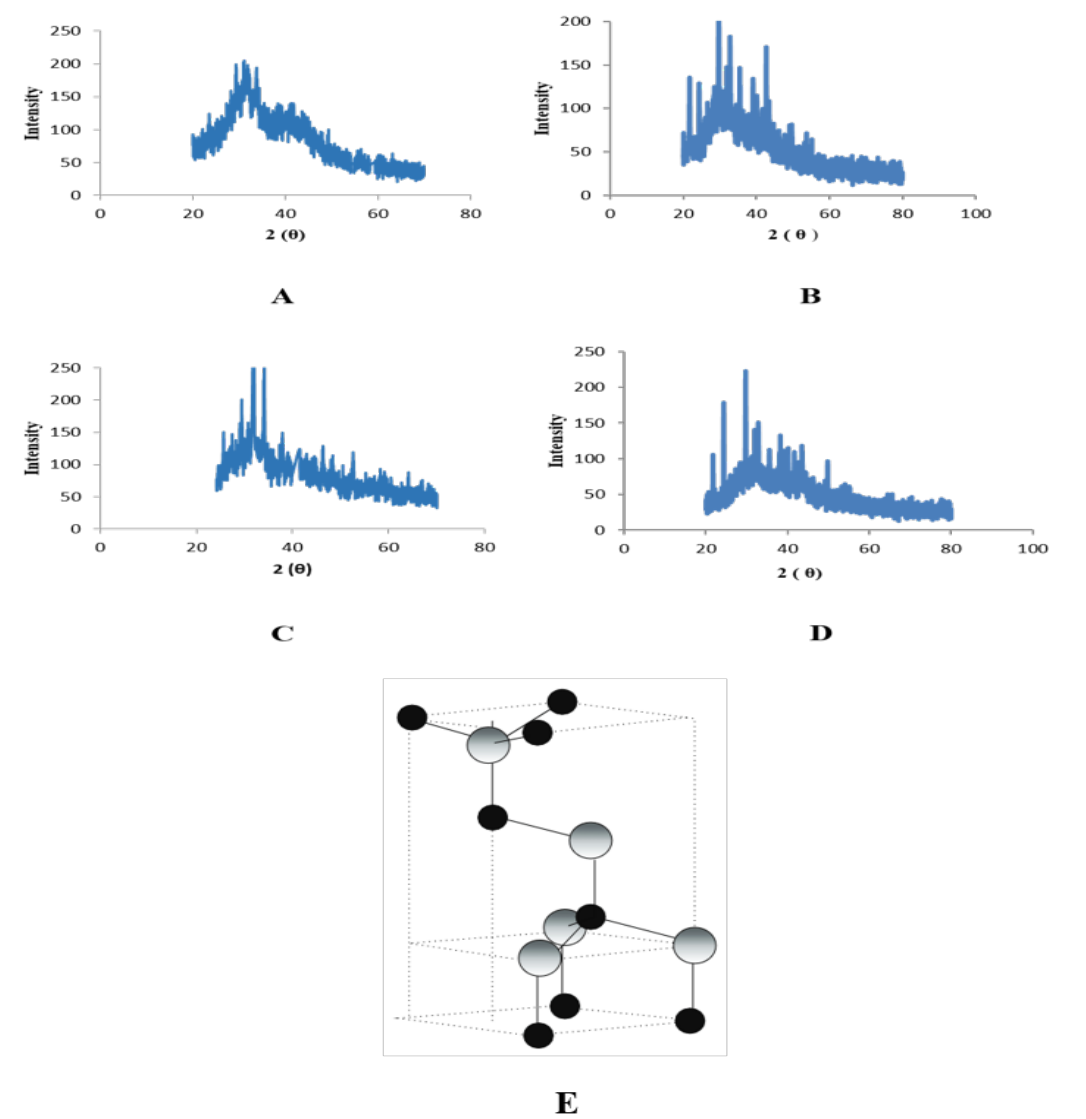
Figure 7. XRD peaks of zinc oxide nanoparticles of roots; ( A ) n-Hexane ( B ) Ethyl Acetate ( C ) Methanol ( D ) Aqueous ( E ) Zinc blende crystal structure of ZnO